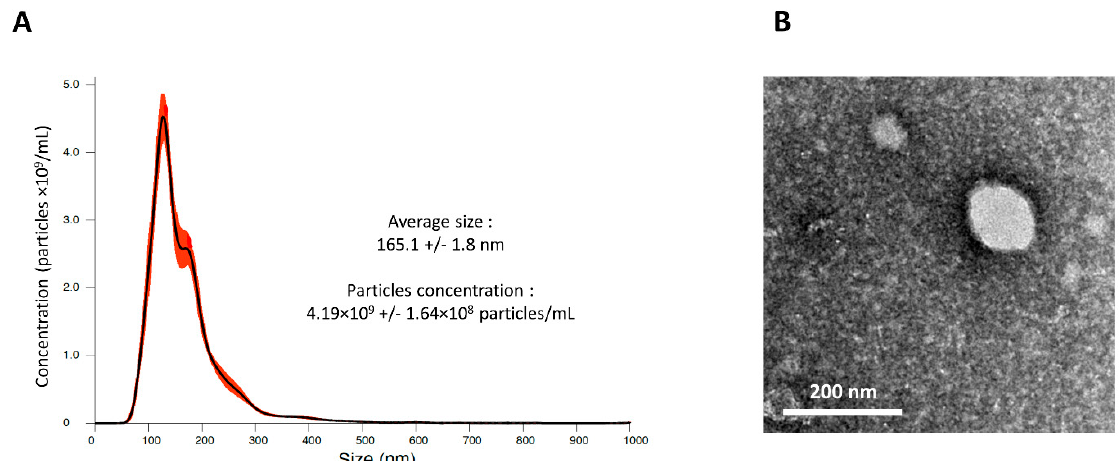
Figure 6. MSC-CM contains undamaged small EVs from BM-MSCs. Conditioned media of equine BM-MSCs were harvested after 24 h of exposure. Then, samples were diluted and prepared to be processed for physical and morphological evaluation of the particles contained in MSC-CM. MSC-CM nanoparticle size distribution and concentration were determined by NTA ( A ). MSC-CM particle morphology was observed by TEM to confirm their EV nature and assess EV integrity ( B ). BM-MSCs - bone marrow-mesenchymal stem cells; MSC-CM - mesenchymal stem cell-conditioned media; EVs - extracellular vesicles; NTA - nanoparticle tracking analysis; TEM - transmission electron micros-